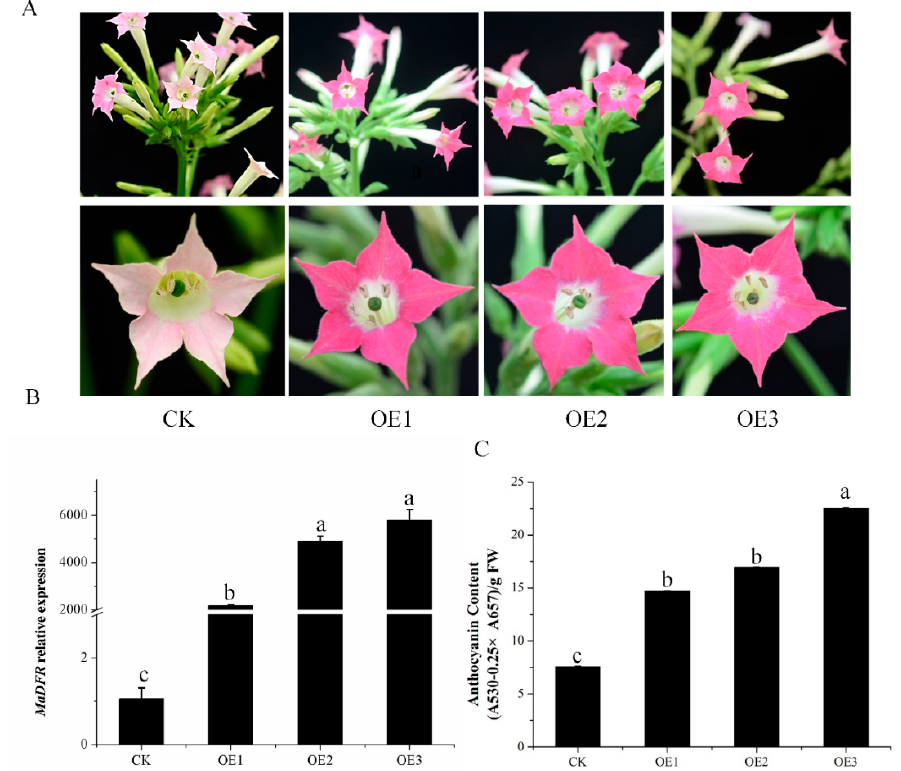
Figure 5. Characterization of transgenic tobacco lines overexpressing MaDFR . ( A ) Phenotypic analysis of MaDFR overexpression (OE1, OE2 and OE3) lines and control (CK) line transformed with pCAMBIA2300 empty vector. Heterologous expression of MaDFR in tobacco resulted in a distinct phenotypic change in petal color. ( B ) Relative expression of MaDFR in tobacco petals of three independent OE lines determined using qRT-PCR. NtTubA1 was used as the internal control. ( C ) HPLC analysis of anthocyanin levels (mg/g fresh weight (FW)) in the petals of the CK line and OE lines. Data represent means ± SEs of three independent replicates. Values which are not significantly different among samples are identified by the same letter (a–c).